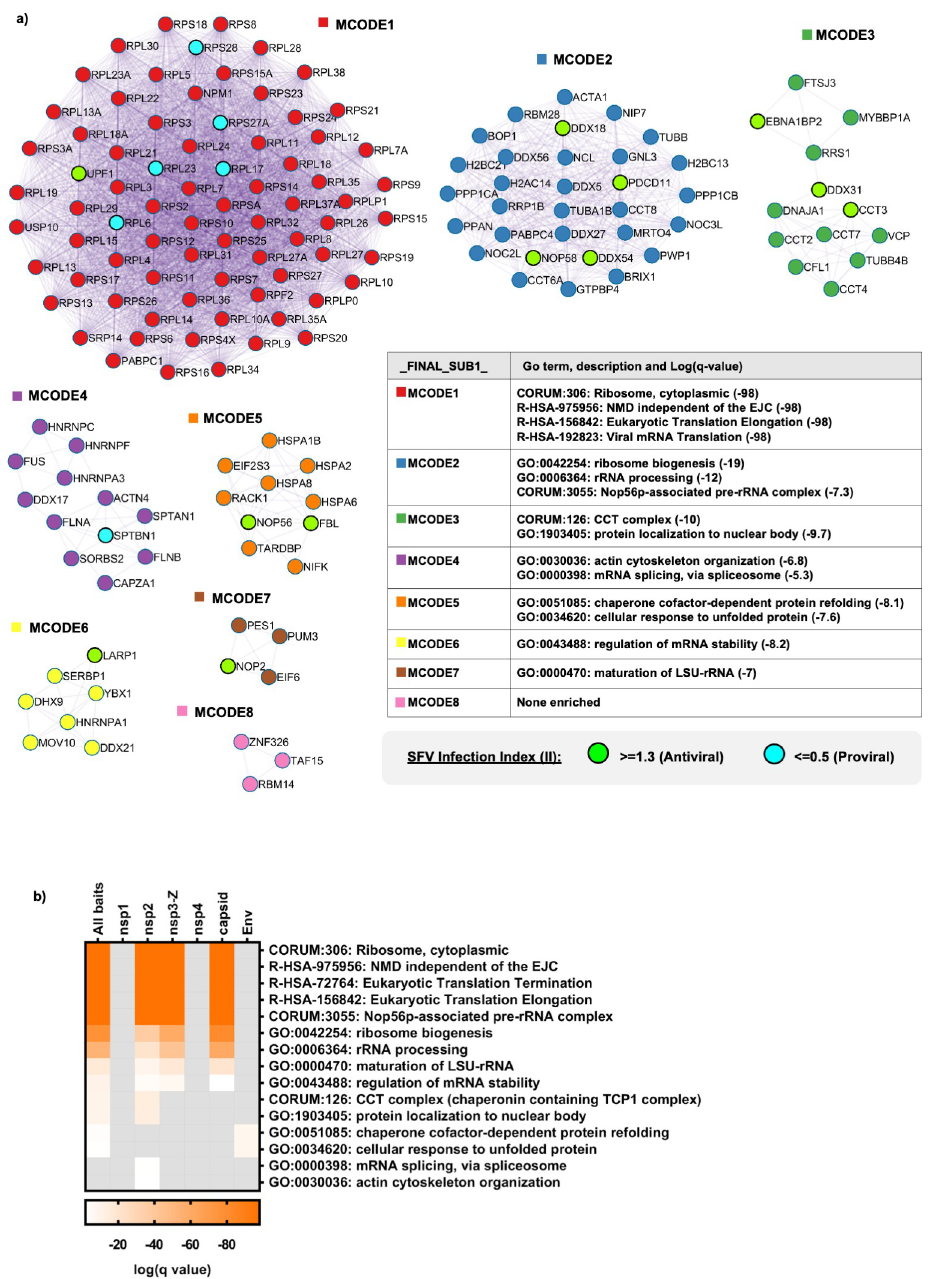
Fig 4. SFV interactors are highly enriched for GO terms related to translation, NMD and ribosome biogenesis. a, Protein-protein interaction enrichment analysis for the full list of SFV interactors was carried out using Metascape with the following databases: BioGrid, InWeb_IM and OmniPath. Densely connected network components were identified by applying the Molecular Complex Detection (MCODE) algorithm and the resultant MCODE networks are displayed. In addition, the proteins identified as having an effect on SFV replication through the siRNA screen are shown within the MCODE complexes (green and turquoise circles). In order to assign biological meanings to the MCODE networks, GO enrichment analyses were performed using the following sources: KEGG Pathway, GO Biological Processes, Reactome Gene Sets, Canonical Pathways and CORUM. All genes in the genome were used as the enrichment background. Between 1–4 GO terms were chosen to represent each MCODE network, with the relevant significance values depicted alongside them. b, Heat map comparing the significance of GO terms (chosen in a) among the different SFV baits. GO enrichment analysis was applied to the set of MCODE networks identified for each individual list (nsp1, nsp2, nsp3-Z, nsp4, capsid and Env), as well as for the merged list (All baits) and the significance values depicted in the heat